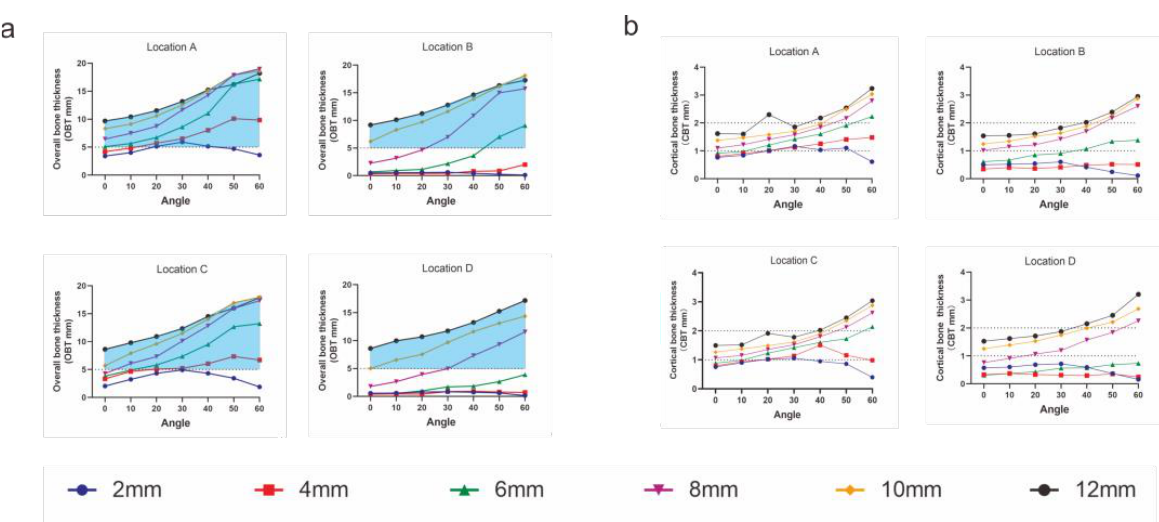
Figure 7. Comparison of OBT and CBT at different insertion heights and angles. ( a ) Overall bone thickness (OBT). The horizontal dotted lines are drawn at a thickness of 5 mm. The colored regions indicated the recommended height levels and insertion angles for mini-implant placement. ( b ) Cortical bone thickness (CBT). Thicknesses of 1 mm and 2 mm are marked with horizontal dotted lines.